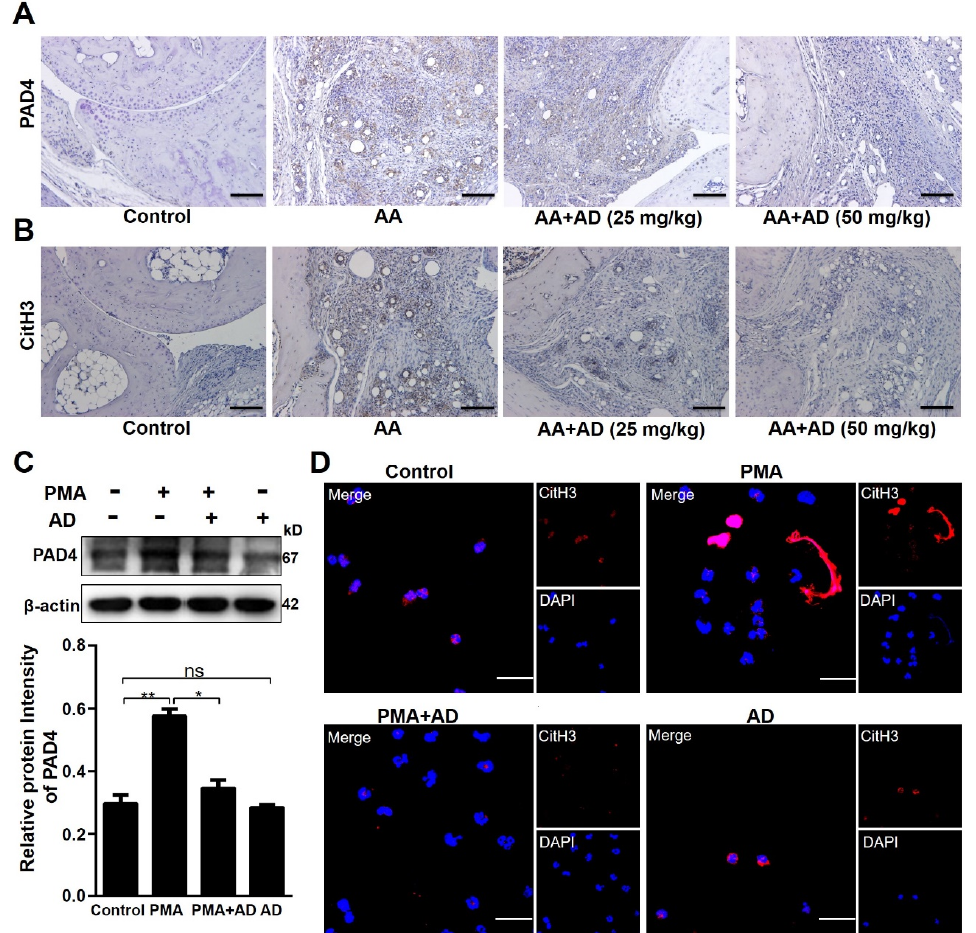
Figure 4. AD inhibited peptidylarginine deiminase 4 (PAD4) expression and histone 3